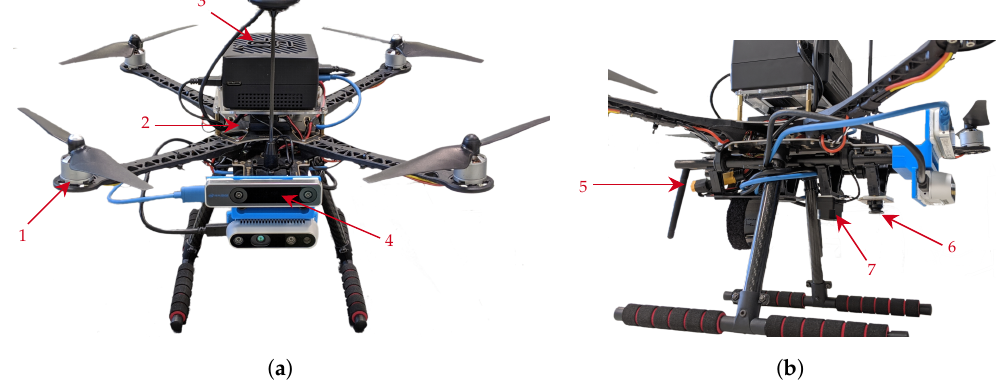
Figure 2. Proposed UAV frame with mounted drivers, companion computer and payload. ( a ) Front view of the UAV displaying: (1) Holybro S500 frame; (2) Pixhawk 4 R (cid:13) flight controller; (3) UP 2 companion computer; and (4) Intel R (cid:13) Realsense TM T265 tracking camera. ( b ) Lateral view of the UAV displaying: (5) 433 MHz telemetry radio; (6) HBV-1615 RGB camera; and (7) TFMini Plus range